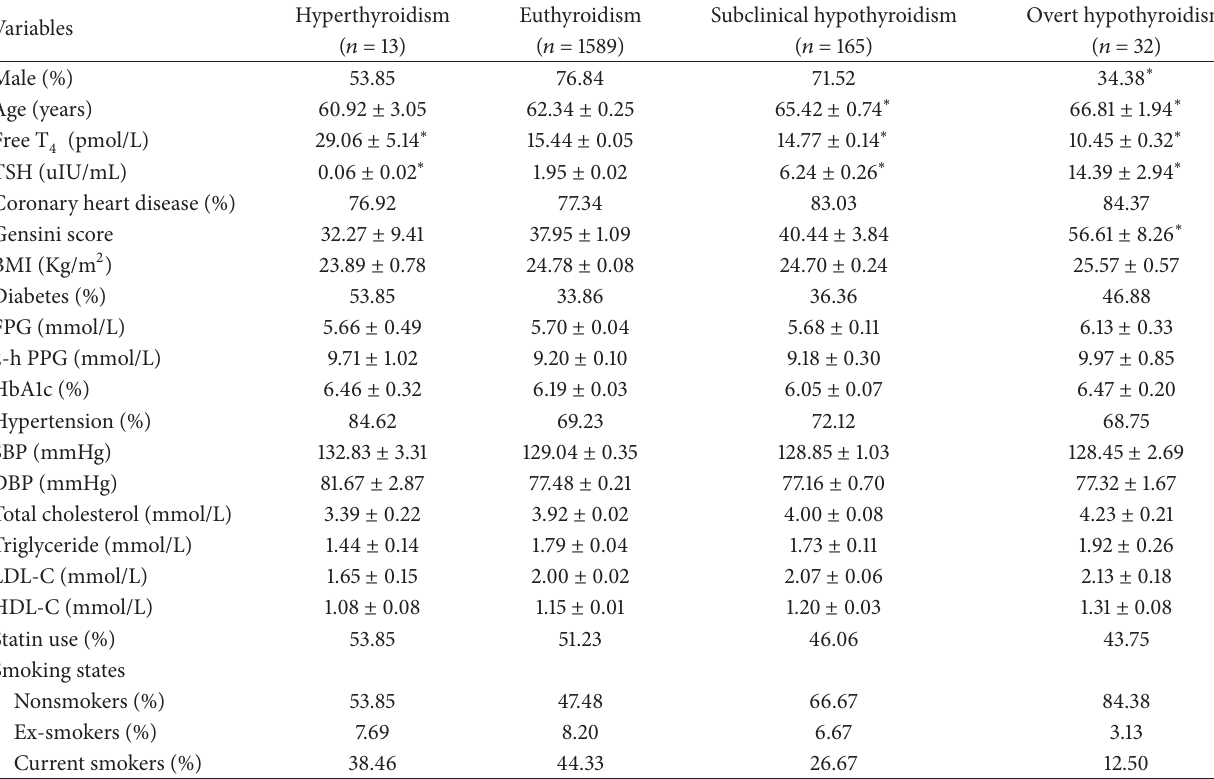
Table 2: Characteristics of the study population by thyroid function